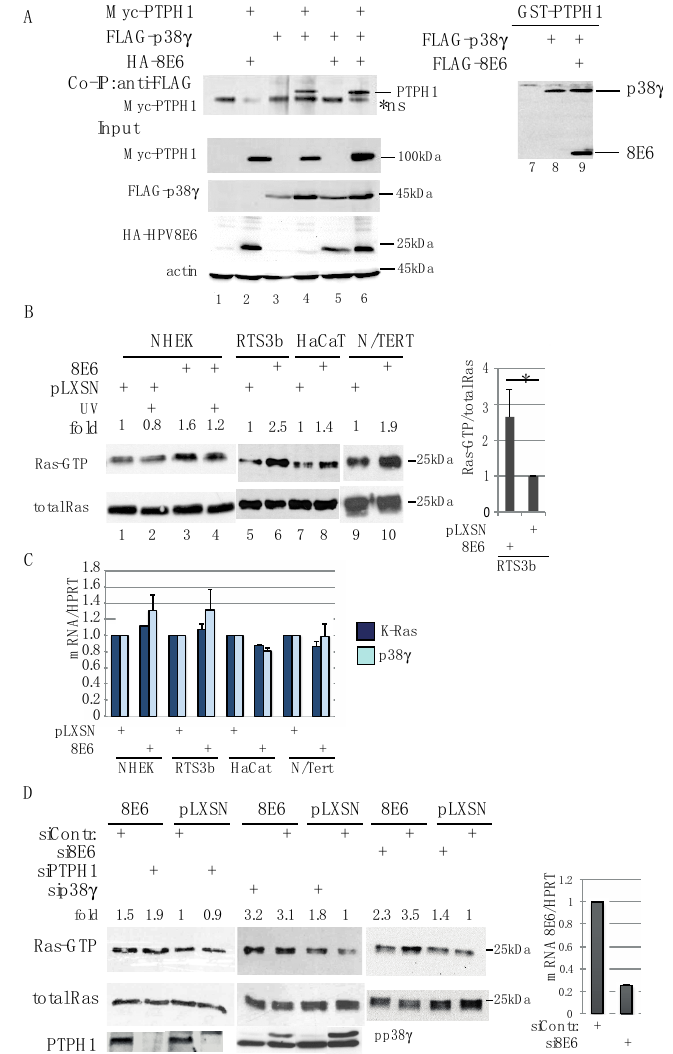
Figure 4. HPV8E6 expressing keratinocytes have increased level of active Ras. ( A ) Co-immunoprecipitation with extracts from C33A cells expressing recombinant FLAG-p38 γ , Myc-PTPH1 and/or HA-HPV8E6 with FLAG beads, as indicated in the figure. The blots were developed with the epitope tag antibodies. In Lanes 7–9, bacterially expressed, purified GST-PTPH1 was incubated with extracts from cells expressing FLAG-tagged p38 γ alone or together with FLAG-HPV8E6. The blot was developed with the FLAG antibody. ( B ) Extracts from pLXSN control or HPV8E6 positive NHEK, RTS3b, HaCaT, or N/TERT, have been incubated with GST-RBD (Ras binding domain of Raf) fusionprotein. Ras was detected in the precipitate as well as in the input by a pan Ras antibody. The graph represents the ratio of precipitated GTP-Ras versus total Ras from 4 independent experiments. The standard deviations as well as the p -values are indicated. ( C ) RNA was isolated from NHEK, RTS3b, HaCaT and N/TERT HPV8E6 and empty vector control cells and qRT-PCR was performed to determine the expression of K-Ras and p38 γ . ( D ) RTS3b-HPV8E6 and control cells were transfected with siRNA against PTPH1 (lanes 1–4), p38 γ and HPV8E6 or non-targeting control (siContr). The extracts were used in a GST-RBD pull down assay. To demonstrate the knock down of p38 γ , siRNA transfected cells have been UV-irradiated 30 min prior harvesting and extracts were used in Western blot with anti-phospho MAPK antibody to detect UV-activated phopho-p38 γ , which is migrating at 43kDa, while the other MAPK members migrate at 38kDa. The fold ratios between GTP-Ras and total Ras are given. RNA form RTS3b-8E6 cells transfected with si-RNA against HPV8E6 or control was used for qRT-PCR to demonstrate the efficiency of the HPV8E6 knock